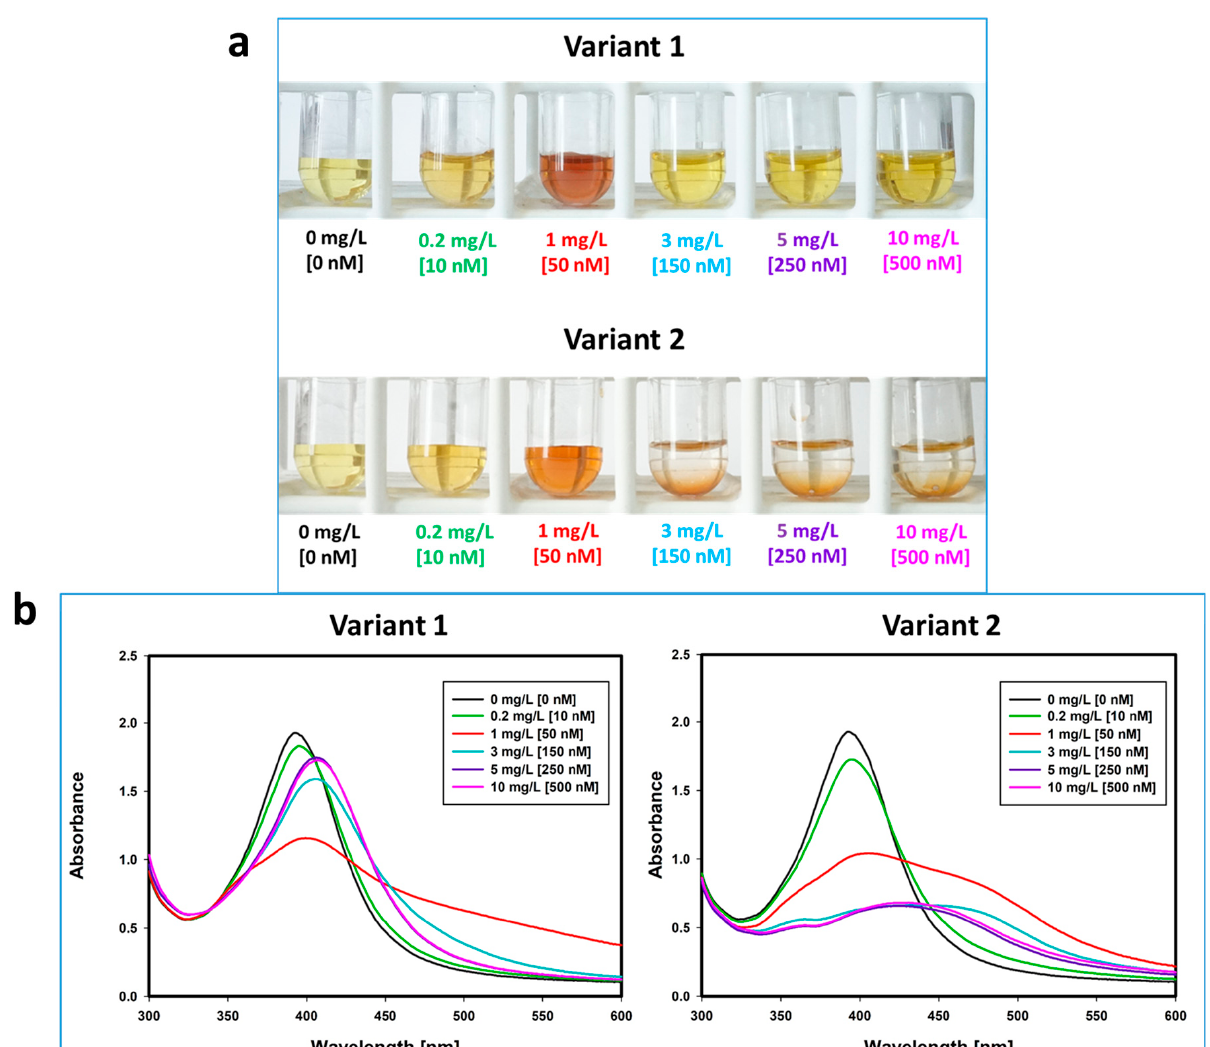
Figure 3. Macroscopic changes ( a ) and localized surface plasmon resonance spectra changes ( b ) observed as a result of functionalizing of silver nanoparticles (10 nM) with various clones of free monoclonal immunoglobulin light chains. In both variants, at the free light chains concentration of 1 mg/L (50 nM), a characteristic red color of the solution was observed, and similar (variant 1 and 2) UV/Vis spectrum changes occurred: a decrease in the absorbance maximum, a broadening of the spectrum and a red-shift. At higher concentrations of the free light chains (above 3 mg/L (150 nM)) in variant 1 the solution was stable and yellow. There was a slight decrease in the maximum absorbance (in relation to the citrate-stabilized nanoparticles) and its shift to the right (red-shift), without broadening of the spectrum. In variant 2, at higher concentrations of the free light chains (above 3 mg/L (150 nM)), aggregation of nanostructures occurred and the spectral line was flattened.